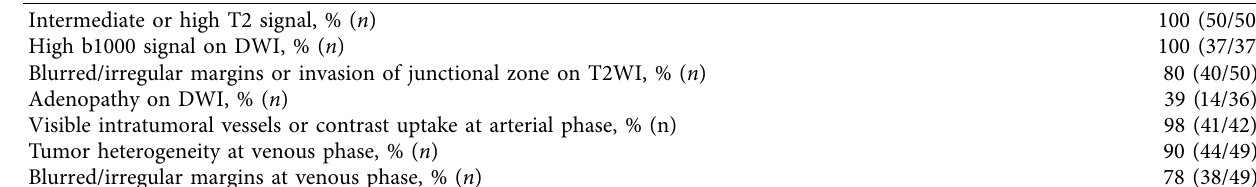
Table 2: Evaluated MRI features for both type 1 and type 2 uterine sarcomas.